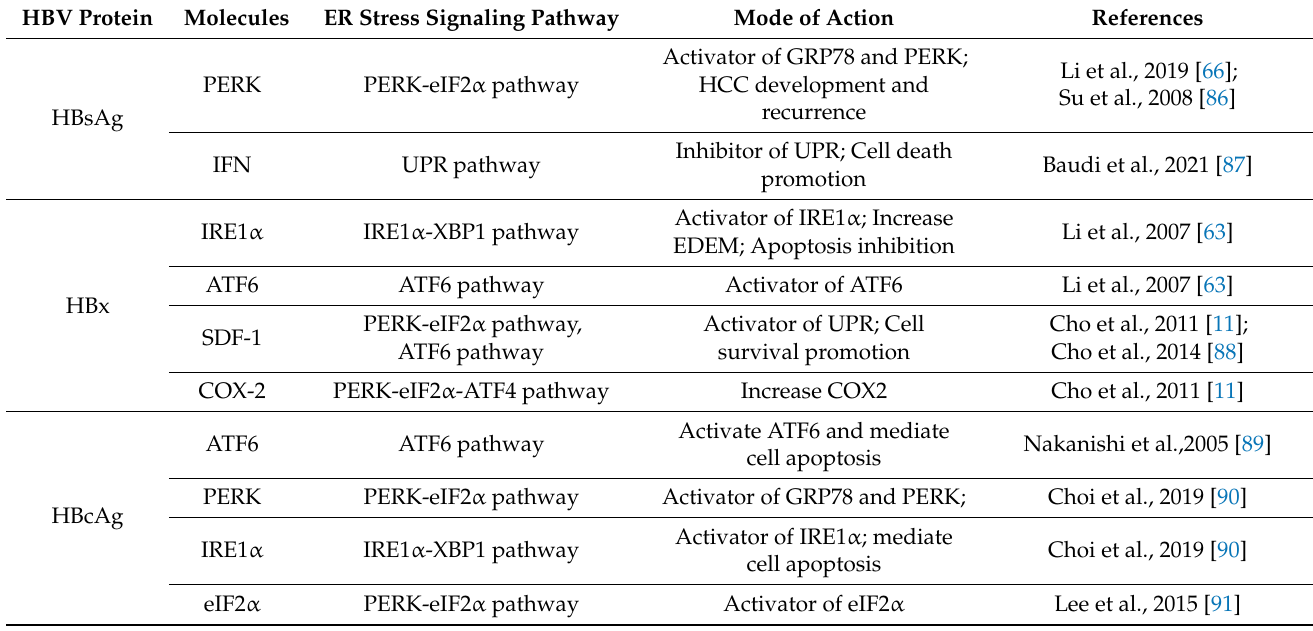
Table 1. Hepatitis B virus and associated ER stress